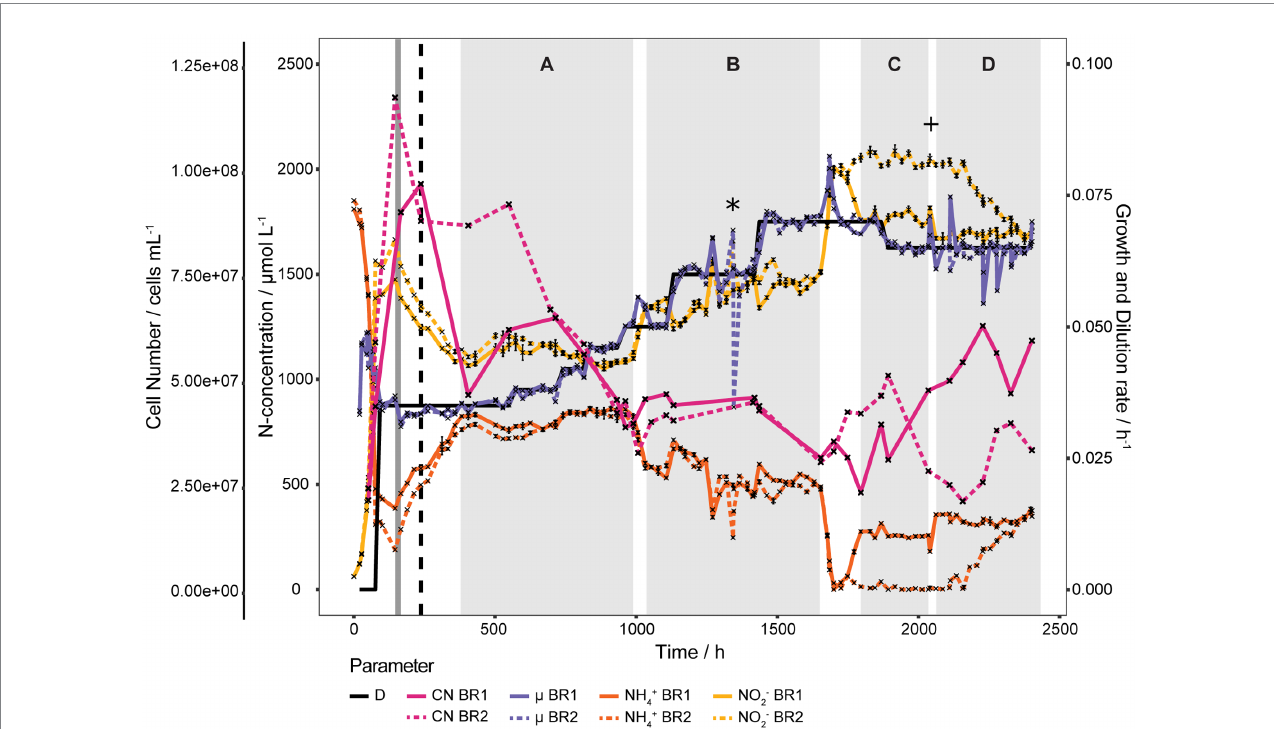
FIGURE 2 Continuous culture of N. viennensis at high D . Two continuous cultures with D ranging from 0.035 h − 1 to 0.070 h − 1 and the development of cell number (CN), NO 2 − derived μ , NH 4+ and NO 2 − concentrations of the cultures grown in the corresponding reactors BR1 and BR2. Cultures were gassed with 1% CO 2 enriched air at 2 sL L − 1 h − 1 gassing rate, except for the period marked in dark grey where the gassing rate was temporarily increased to 10 sL L − 1 h − 1 . The black dashed line indicates the increase to 2% CO 2 in the in-gas. Sections A to D signify regions where NH 4+ concentrations stabilized, even though D was increased. Spontaneous increases of activity happened between section A and B and section B and C without external influences. Increase of NH 4+ of BR1 from section C to D was due to an increase of reactor working volume and the increase of NH 4+ of BR2 in section D was probably induced by taking larger sampling volumes. The asterisk indicates the point of contamination of BR2 due to a ripped pump tube and the plus sign indicates the point at which the contamination was no longer detectable by PCR of the bacterial 16S rRNA gene. NH 4+ and NO 2 − curves show mean values of technical triplicates and error bars represent the standard deviation of the mean. Points with small standard deviation may not have visivle error